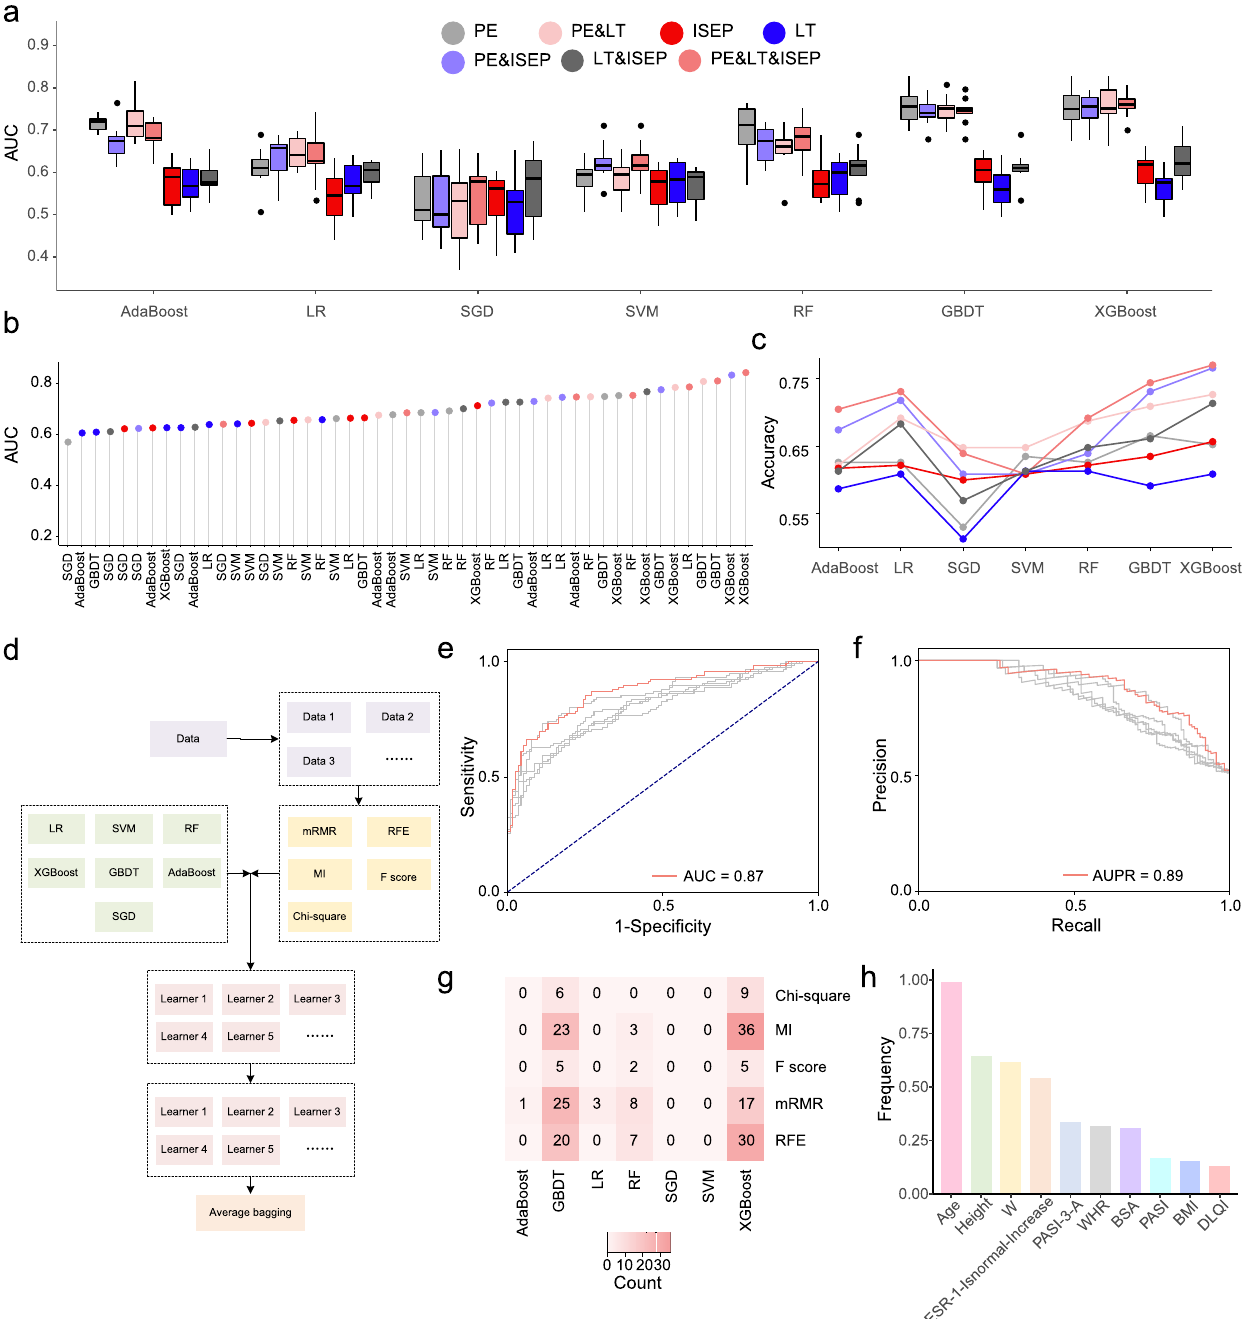
Fig. 3 Performances of different models for predicting PsA. a The AUC values of different models trained using different categories of features and their combinations via the 10-fold cross-validation test based on the training datasets. The central line marks the median AUC value, and the bounds of the box mark the fi rst and third quartiles. b The AUC values of models trained with different categories of features and their combinations using the test dataset. c The model accuracy values based on different categories of features and their combinations evaluated on the test dataset. d A fl owchart of the proposed PsA prediction model. Comparison of ROC curves e and PR curves f on the test dataset. The red curve represents the prediction performance of the proposed PsA model. The grey curves represent the prediction performances of the fi ve best-performing base classi fi ers. g A summary of the most signi fi cant feature strategies and machine learning methods of the proposed PsA diagnosis model. ‘ Count ’ demonstrates the times that the combination of the machine learning method and the feature selection technique has been selected in the fi nal ensemble model across 40 datasets. h A summary of the most important features of the proposed PsA diagnosis model. PE physical examination. LT laboratory test. ISEP the indices for severity and extent of psoriasis. W waistline. WHR waist-hip ratio. DLQI dermatology life quality index. ESR erythrocyte sedimentation